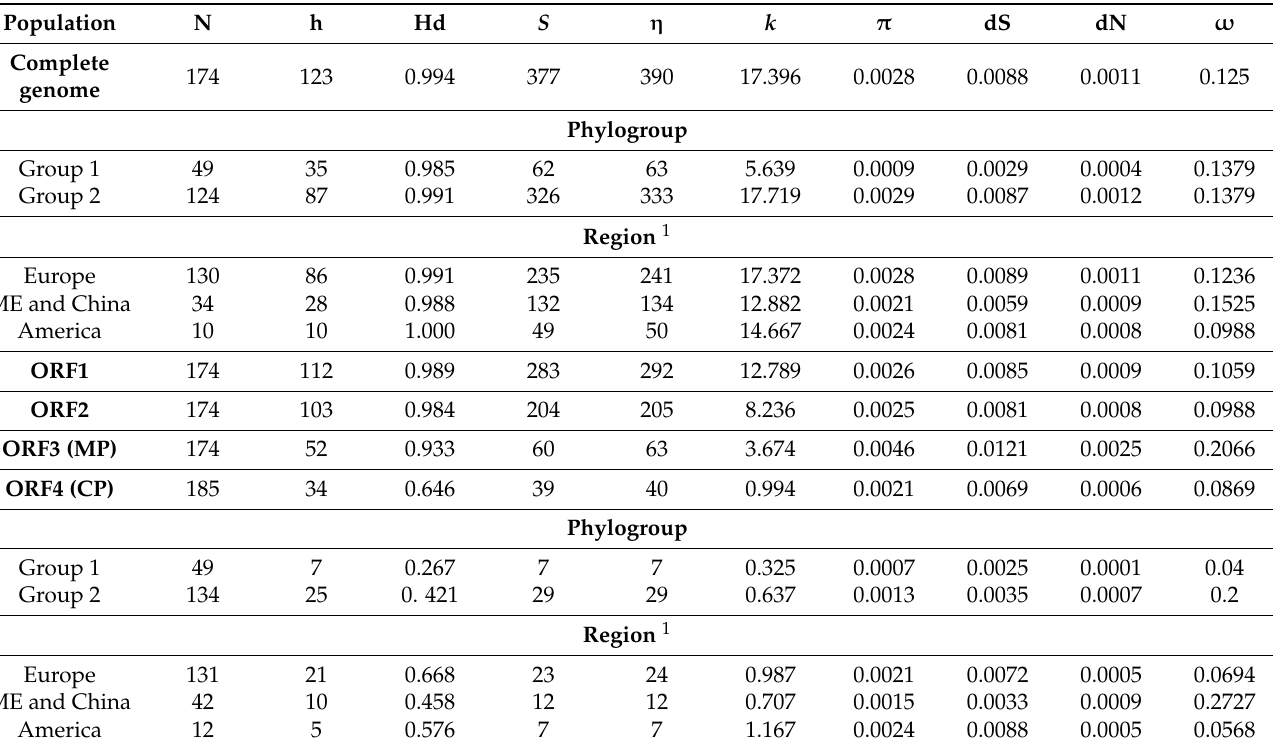
Table 1. Genetic diversity and polymorphism analyses of the complete genome, ORF1, ORF2, ORF3 (MP), and ORF4 (CP) of ToBRFV from different phylogroups and